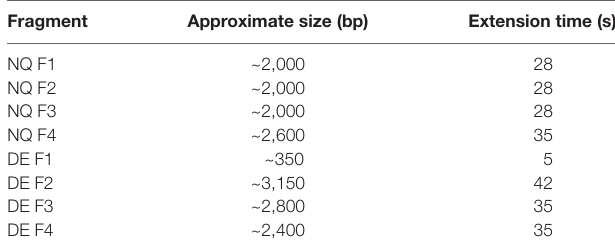
Table 2 | PIPE PCR fragments with accompanying specific PCR extension times for fragment